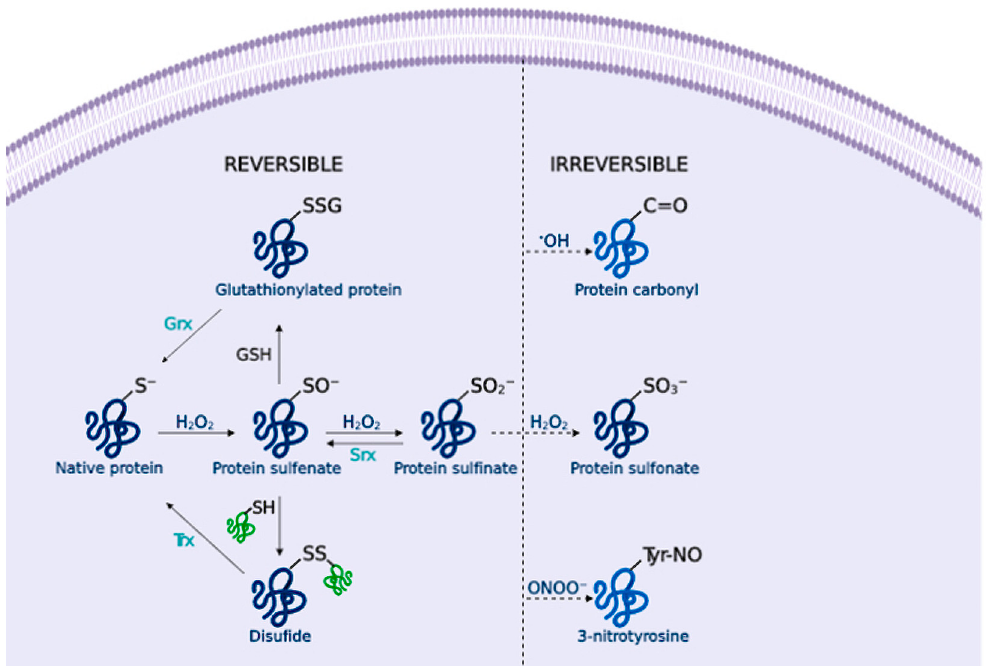
Figure 2. Cysteine redox modification by H 2 O 2 . Low H 2 O 2 concentrations lead to sulfenates (SO¯) formation that can form disulfide (SS) or glutathionylated proteins (SSG), and sulfinates (SO 2 ¯). These modifications can be reversed by thioredoxins (Trx), glutaredoxins (Grx) or sulfiredoxins (Srx). Under OS, the formation of sulfonate (SO 3 ¯) leads to irreversible damage. Likewise, amino acid oxidation by ˙ OH or ONOO¯ forms protein carbonyls and 3-nitrotyrosine residues that alter the protein function.